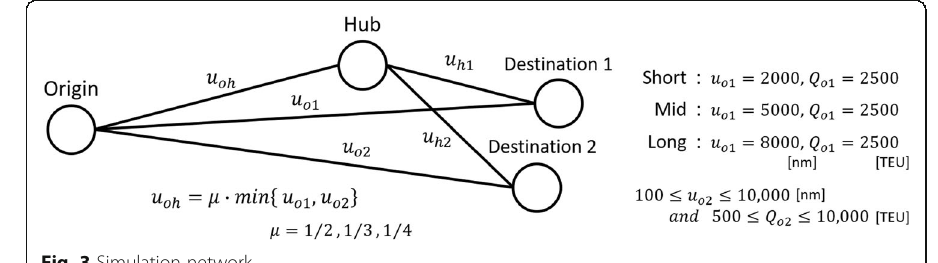
Fig. 3 Simulation network